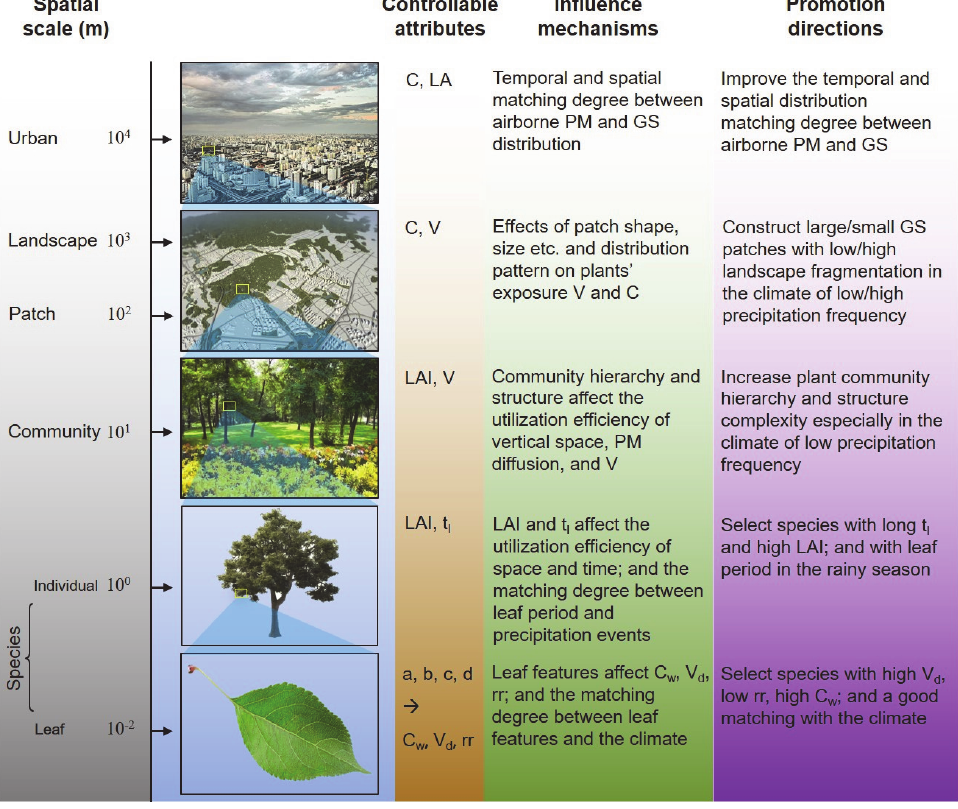
Figure 1. Controllable attributes, influence mechanisms, and promotion directions of particulate matter (PM) removal by green space (GS) at each scale. C w , wash ‐ off coefficient of precipitation on leaf PM; V d , deposition velocity of PM; C, PM concentration in the air; rr, hourly PM resuspension rate; LA, leaf area; LAI, leaf area index; V, wind speed; a, b, c, and d, species attributes that affect C w , V d , and rr.